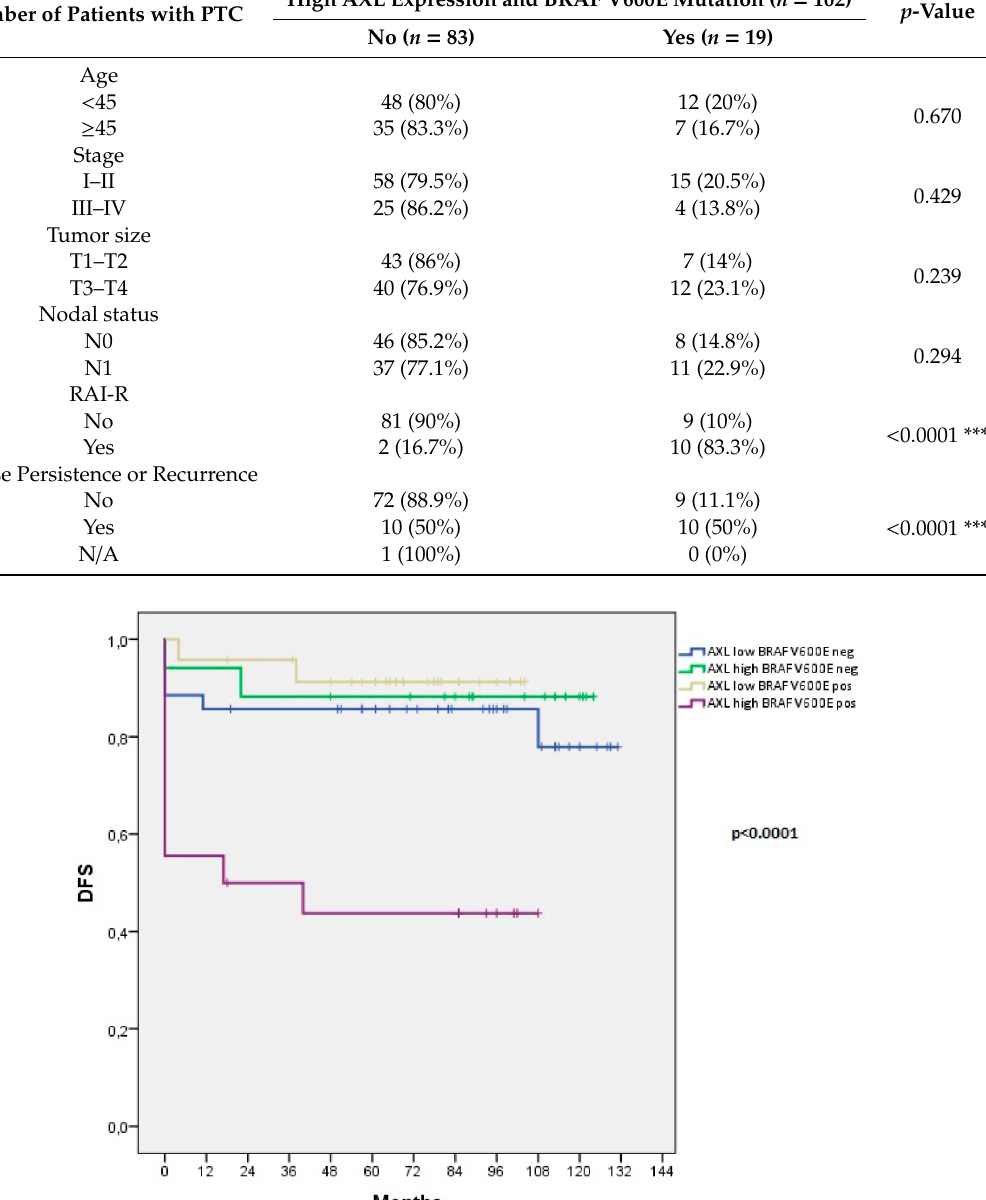
Table 4. Correlation analysis with clinico-pathologic features in the group of patients expressing both BRAF V600E mutation and high AXL expression. RAI-R: Radioactive Iodine-Refractoriness. *** p ≤ 0.001. Number of Patients with PTC